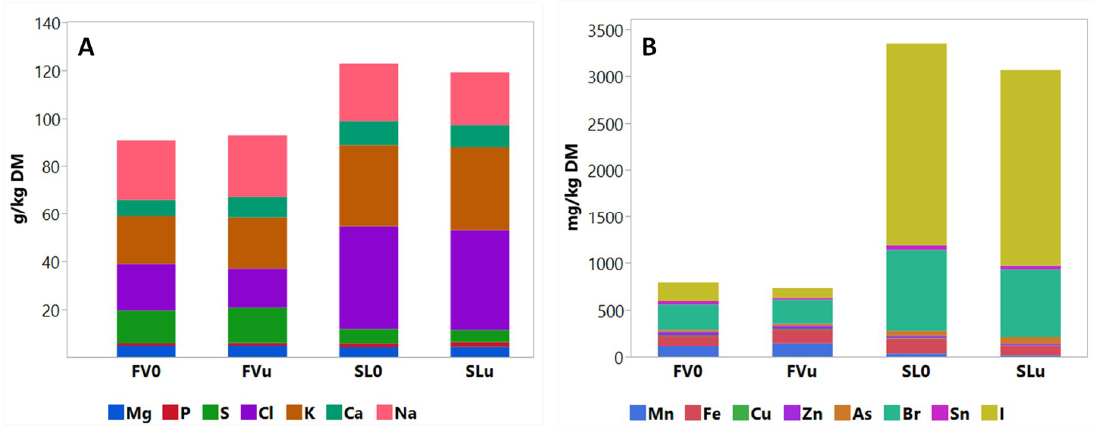
Figure 2. The macromineral ( A ) and trace element ( B ) composition of Fucus vesiculosus (FV) and Saccharina latissimi (SL) before (0) and after ensiling (u: no inoculant) .